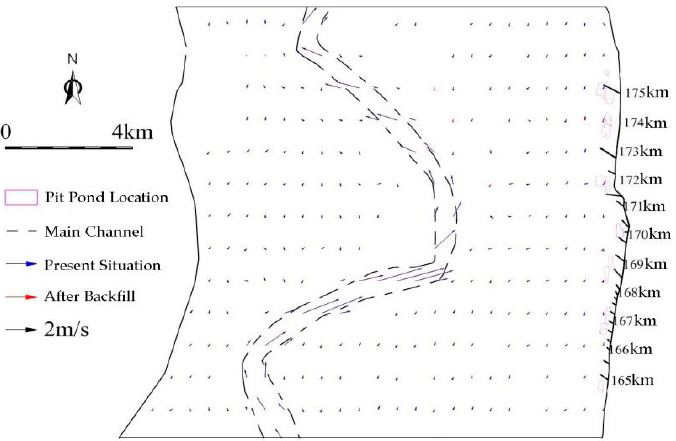
Figure 5. Variation of flow field under the floodplain condition (Q = 7000 m 3